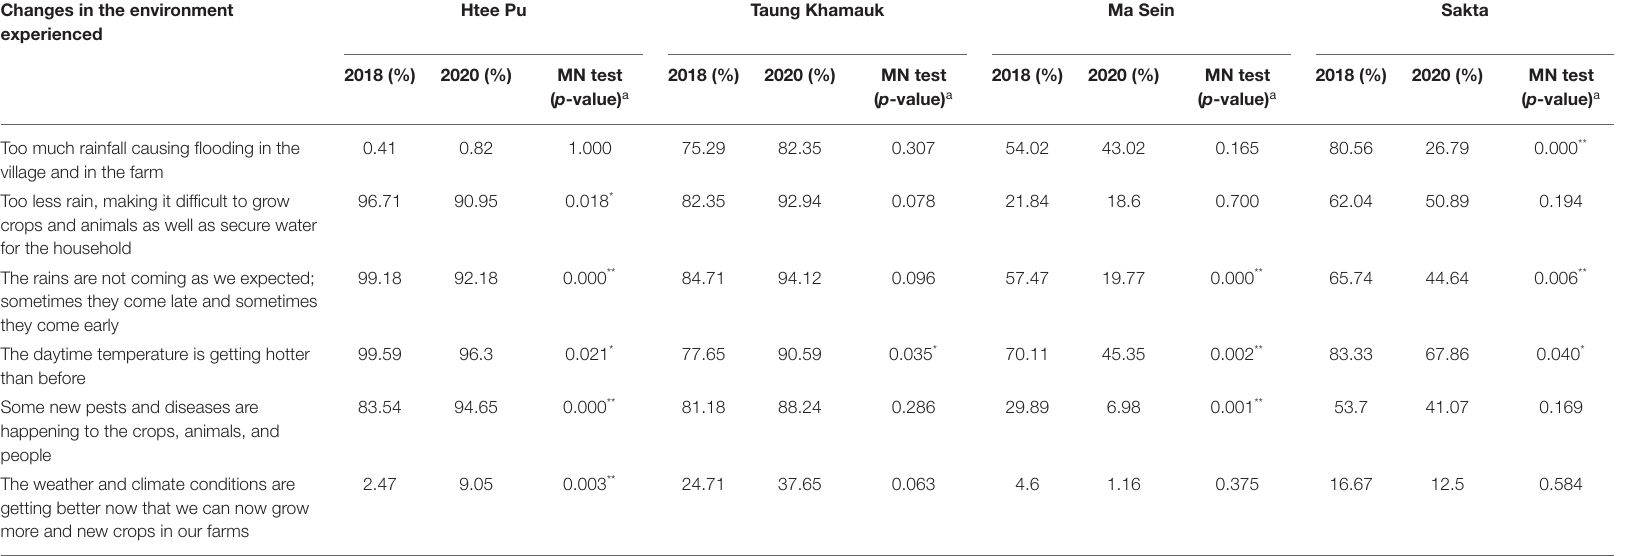
TABLE 4 | Changes in the environment experienced by CSV,